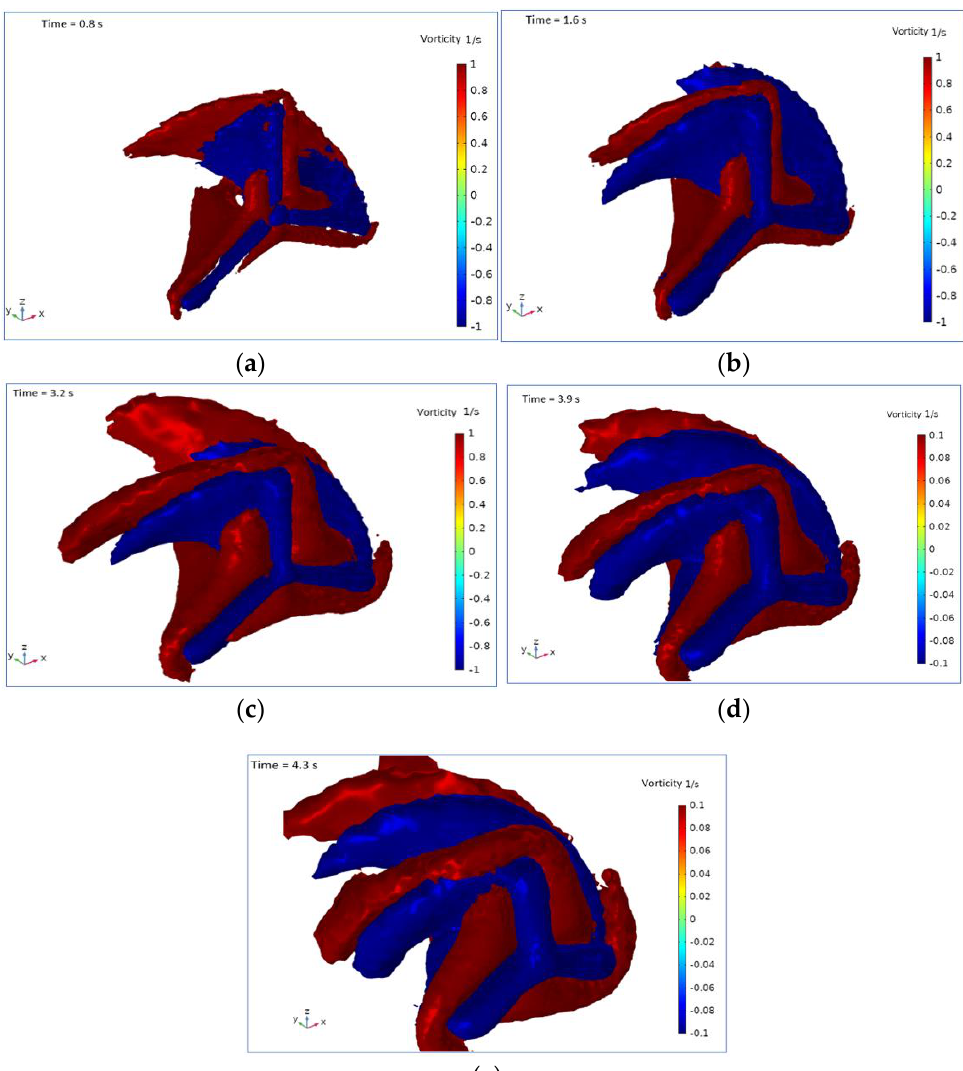
Figure 6. Time frames depicting the formation of the near-wake helical vortex pair structure in the downstream of the rotating turbine at ( a ) t=0.8 s; ( b ) t=1.6 s; ( c ) t=3.2 s; ( d ) t=3.9 s; ( e ) t=4.3 s.